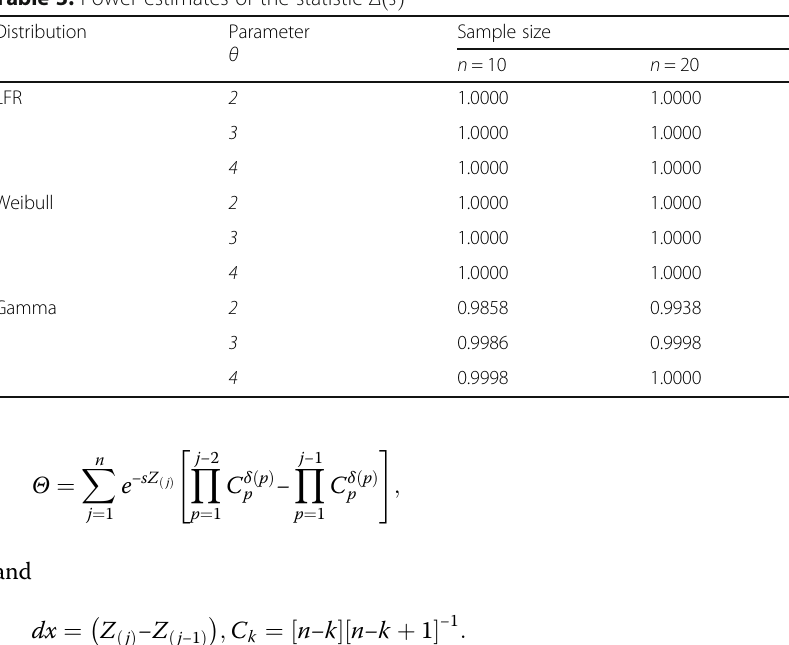
^ Δ s Þ test for sample size n = c ð